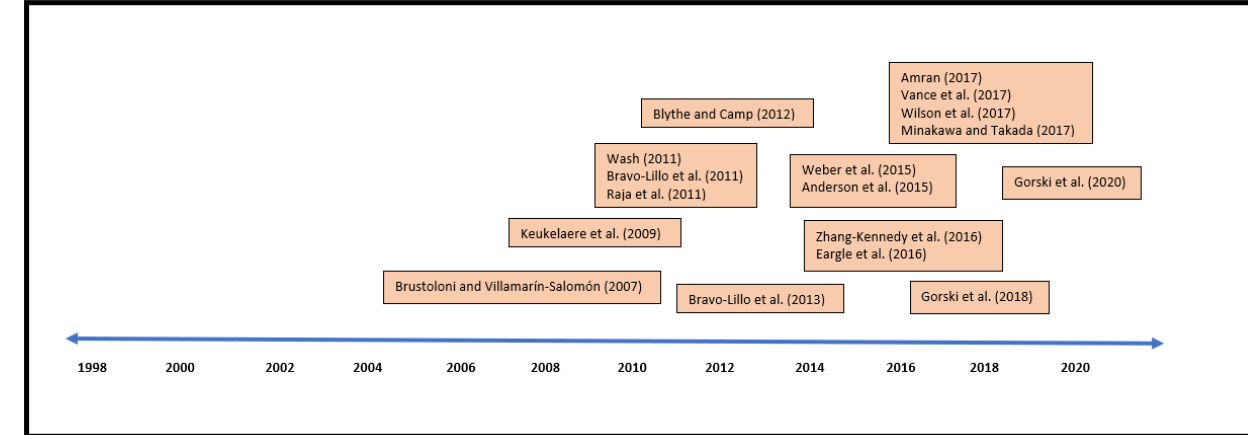
Figure A2. Timeline of approaches to improving security warnings.